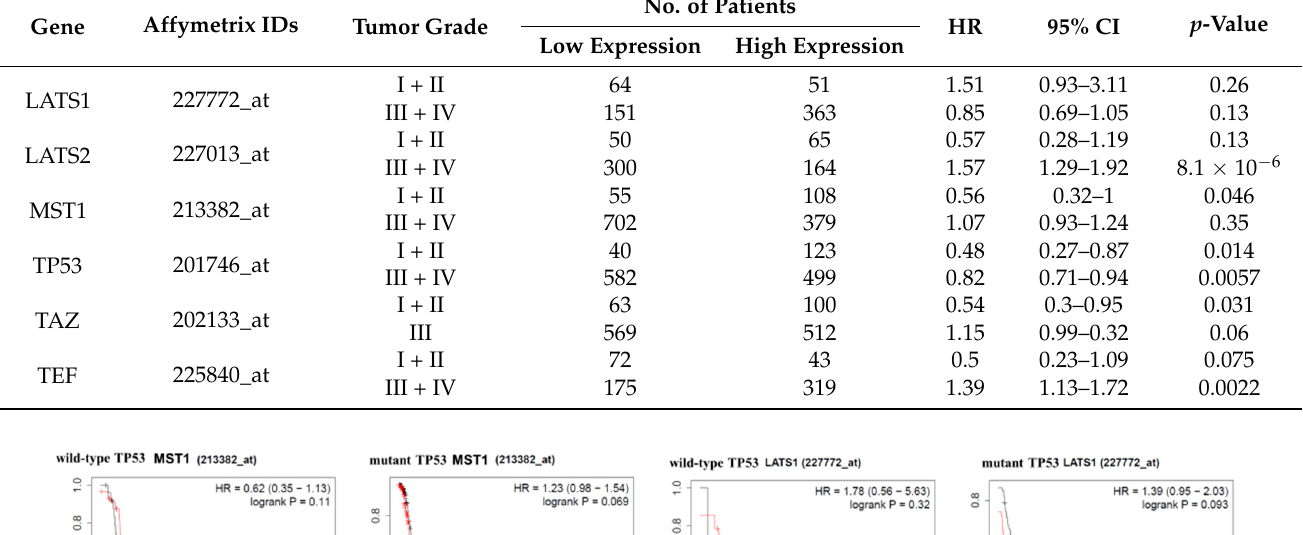
Table 2. Correlation of key Hippo genes with PFS according to tumor grade, hazard ratio, and 95% confidence interval.